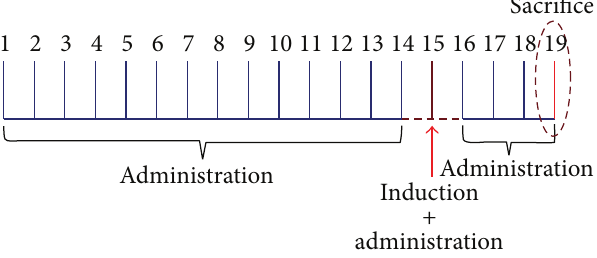
Figure 5: Pretreatment with Royal Jelly (100, 150, and 200 mg/kg) for 14 consecutive days followed by the administration of TNBS (induction of colitis) on day 15. The following 3 days (16, 17, and 18), animals received RJ (100, 150, and 200 mg/kg) and were sacrificed on day